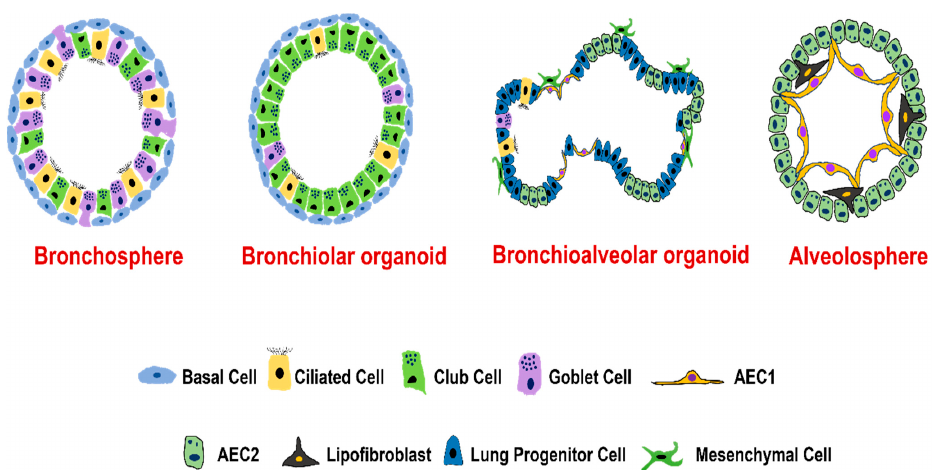
Figure 2. Types of lung organoids: Types of organoids derived from different parts of the lung. Airway basal cells form bronchospheres/tracheospheres made up of basal cells, ciliated cells, club cells, goblet cells. Alveolar type-2 cells along with adult human lung mesenchymal cells can generate bronchiolar organoids which consist more of club cells, ciliated cells, basal cells, and goblet cells. Bronchioalveolar organoids consist primarily of AEC2 cells, AEC1 cells, lung progenitor cells, ciliated cells, and mesenchymal cells. The alveosphere mainly contains AEC2 cells, AEC1 cells, and lipofibroblasts.